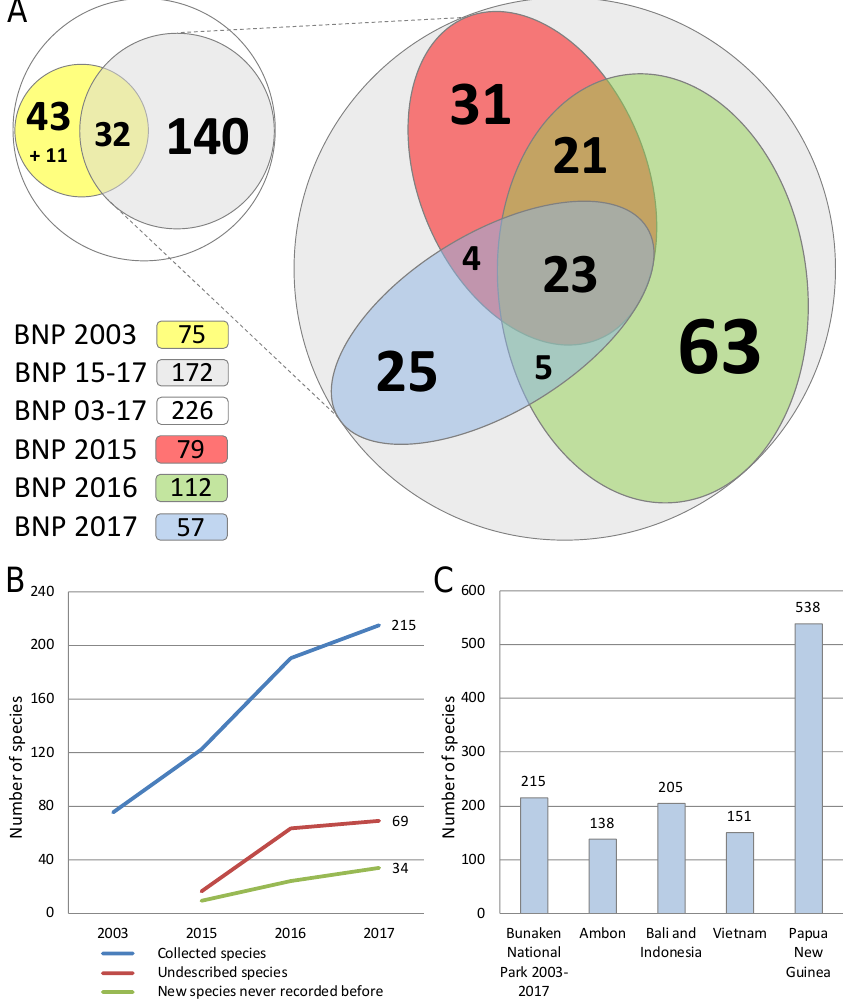
Figure 21. Summary of species numbers and overview in Bunaken National Park (BNP): ( A ) Comparison of collection efforts of the years 2003 with 2015, 2016, and 2017. ( B ) Species accumulation curves of overall species numbers (blue line), of undescribed species (red line), and of species that are not documented in literature or identification books, thus representing at-the-moment-unique species of BNP, North Sulawesi (green line). The species number for the collection event 2003 does not contain the 11 species that could not be reassessed. ( C ) Comparison of species numbers from geographic areas close by North Sulawesi. Data based on BNP: Kaligis et al. [1], Burghard et al. [3], and this study; Ambon [12–14,17]; Indonesia with emphasis on Bali [37]; Vietnam [16]; and Papua New Guinea